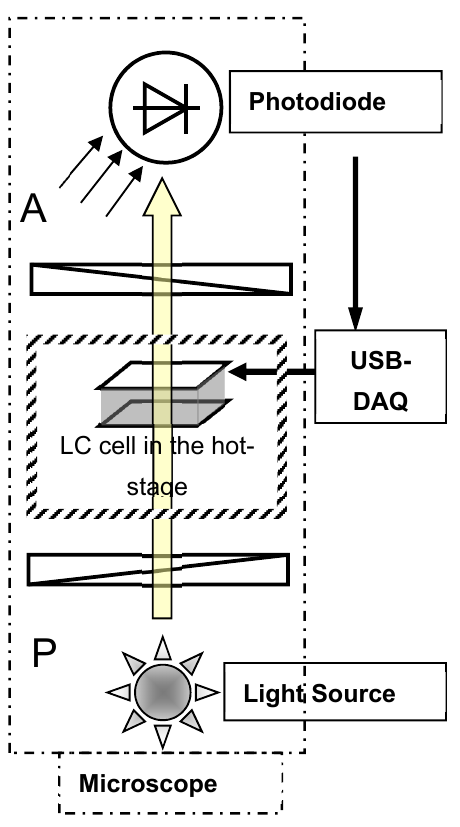
Figure 1. The polarising microscope set-up for electro-optical experiments. An LC cell is mounted in the hot-stage. The Polariser (P) and the Analyser (A) of the microscope are crossed with each other. The photodiode is mounted in the camera port. The output is connected to the National Instrument Data Acquisition Board (DAQ) and to the different input channels of the oscilloscope. The signal across the cell is also drawn from DAQ and is amplified by the power amplifier as needed.